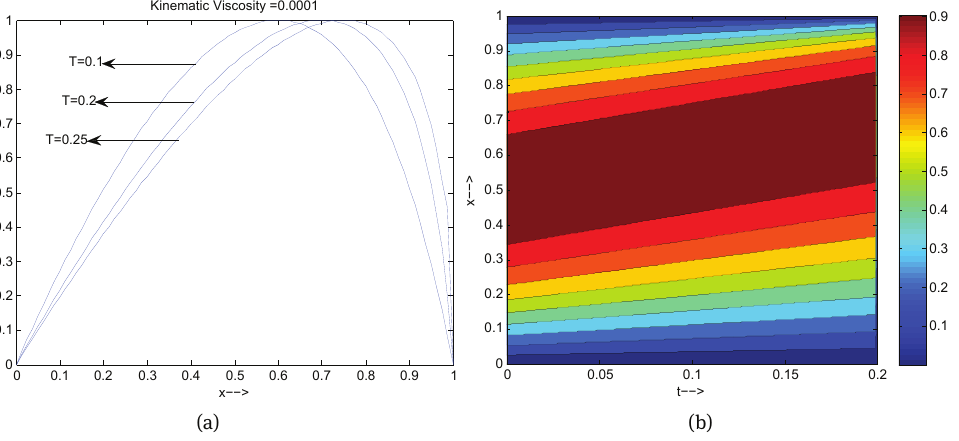
Fig. 15: Physical behavior of numerical solutions for Example 2 in 2D and contour form for ν = 0.0001 at different times with Δx = 0.0125 and Δt = 0.001 .